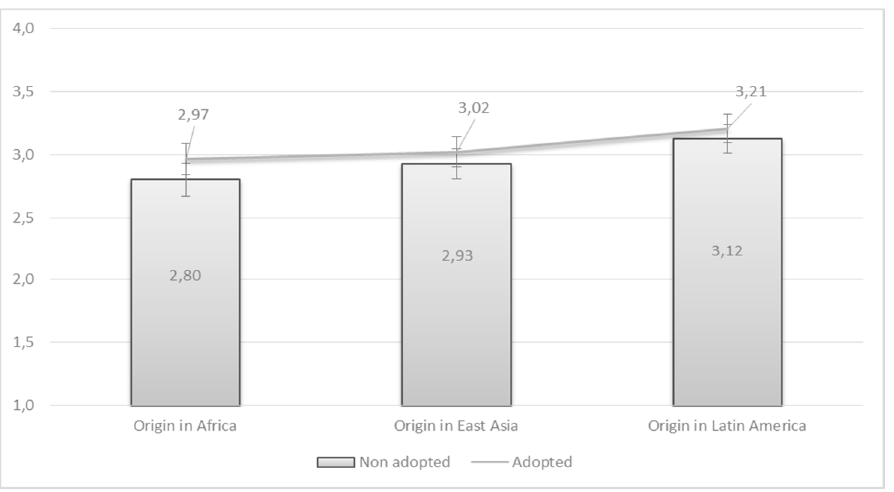
Note: 1 represents negative responses and 4 represents positive answers. The numbers represent the mean attitudes. Figure 2. Attitudes towards interracial marriage: Comparison of white European respondents’ attitudes towards non-white adoptees and non-white migrants.